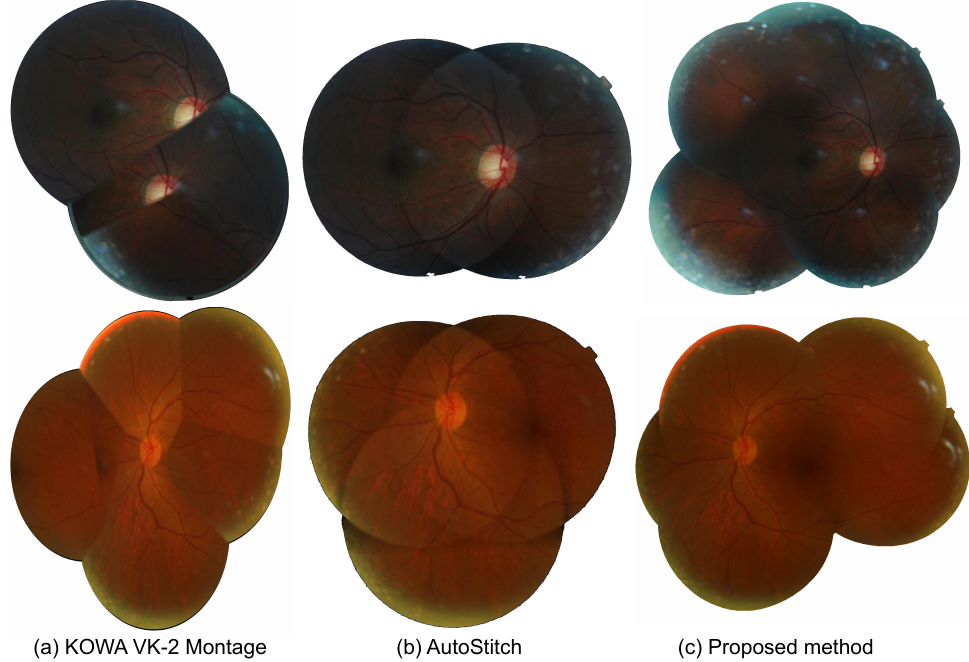
Figure 9. Comparison of Mosaic images constructed by different application. ( a ) KOWA software. ( b ) AutoStitch. ( c )